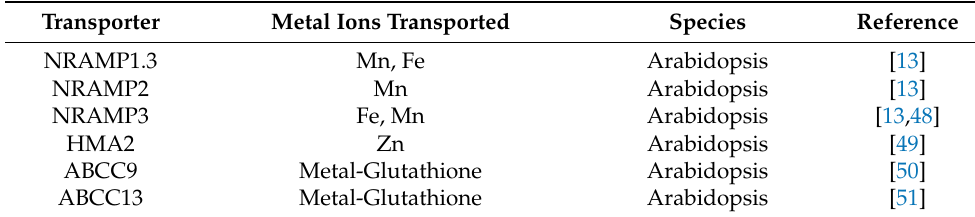
Table 1. Main features of metal transporters investigated in this study in Populus alba